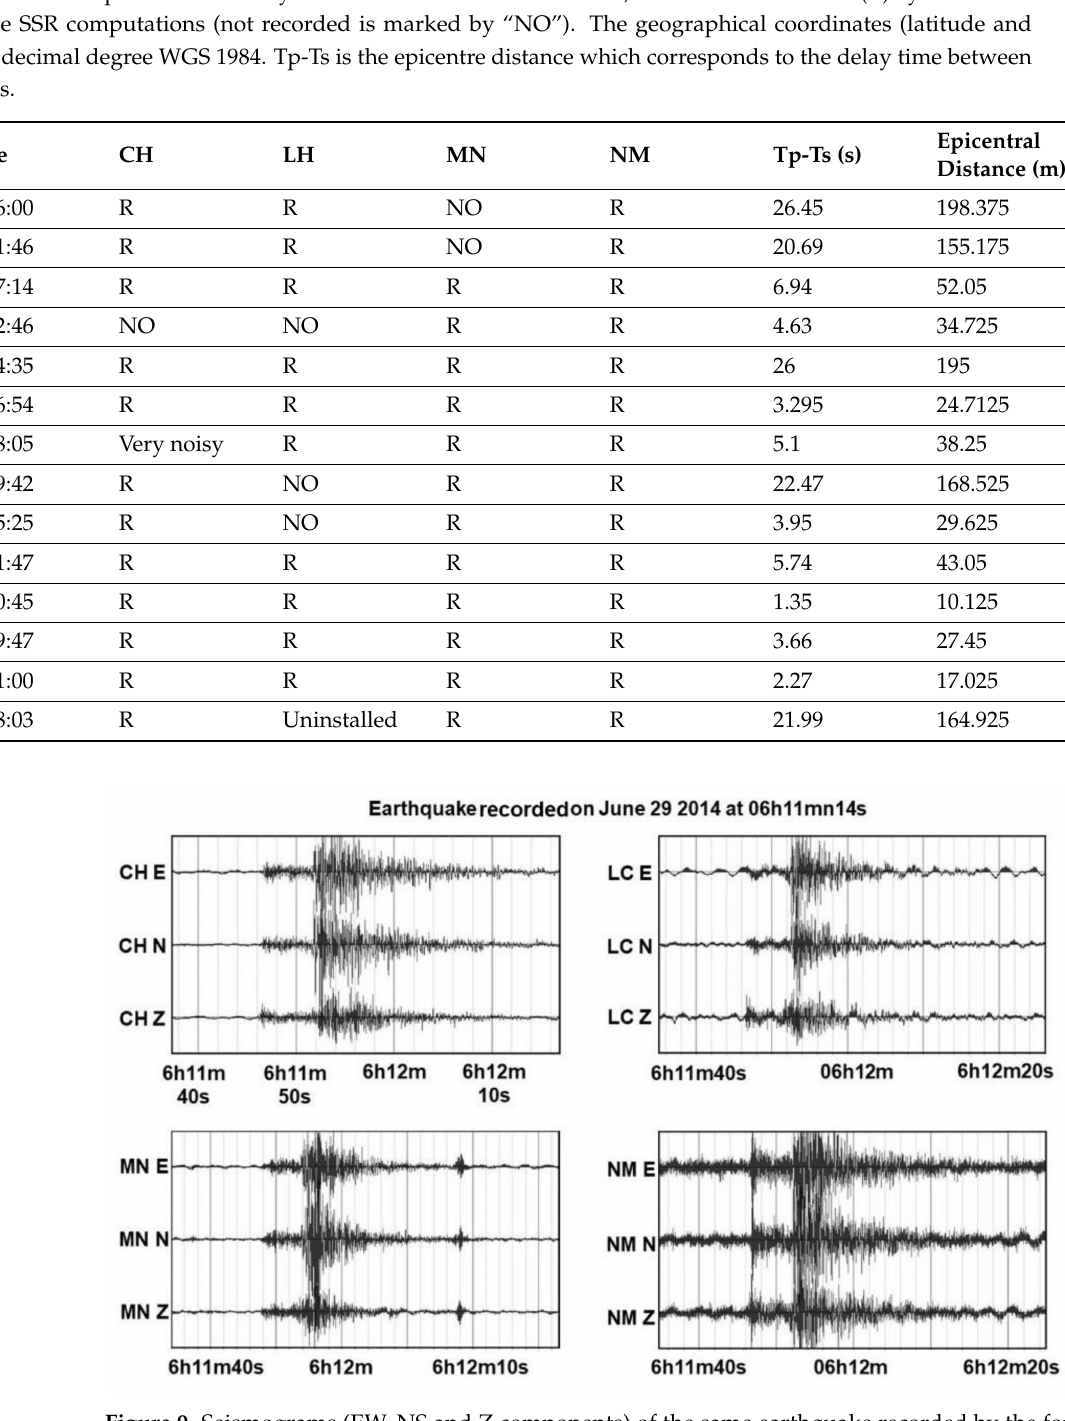
Figure 9. Seismograms (EW, NS and Z components) of the same earthquake recorded by the four temporary stations installed in Fond